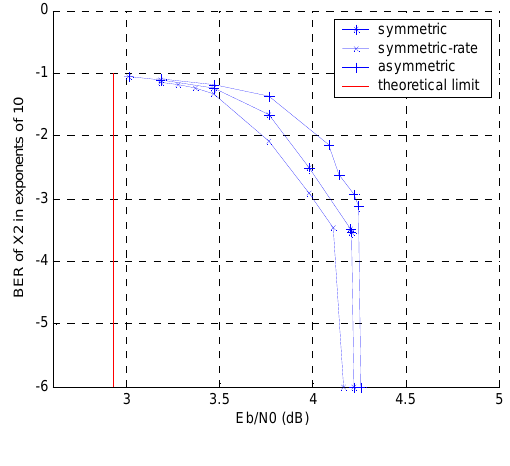
in the three sources DJSCC 2